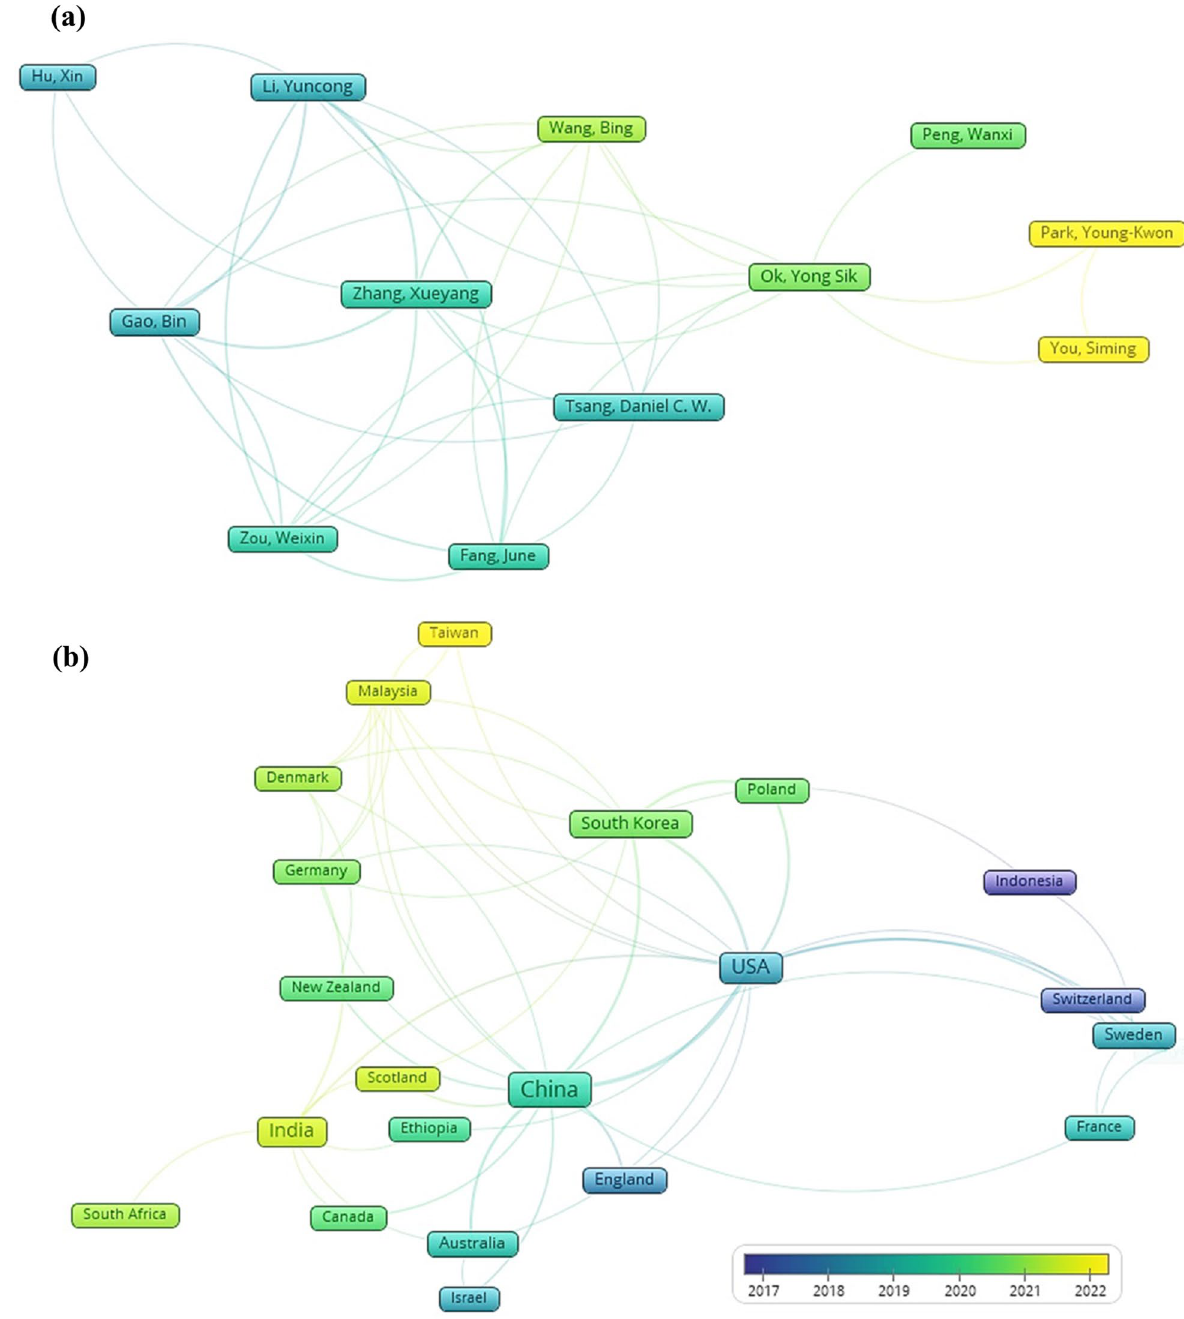
Fig. 8 Bibliometric network for treatment of contaminated air between a authors and b countries for minimum 3 document